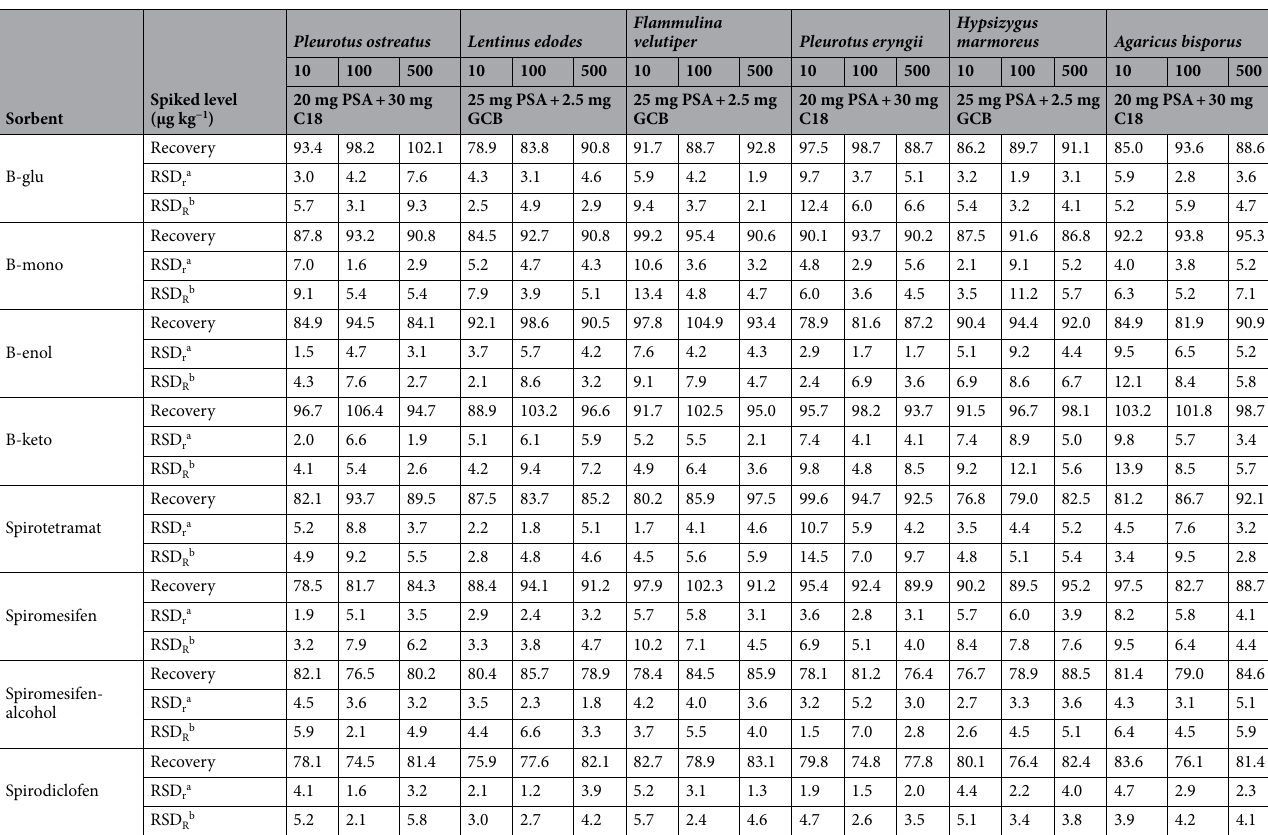
Table 3. Recoveries (n = 15, %), RSD ra and RSD Rb (%) for target compounds from different matrixes at